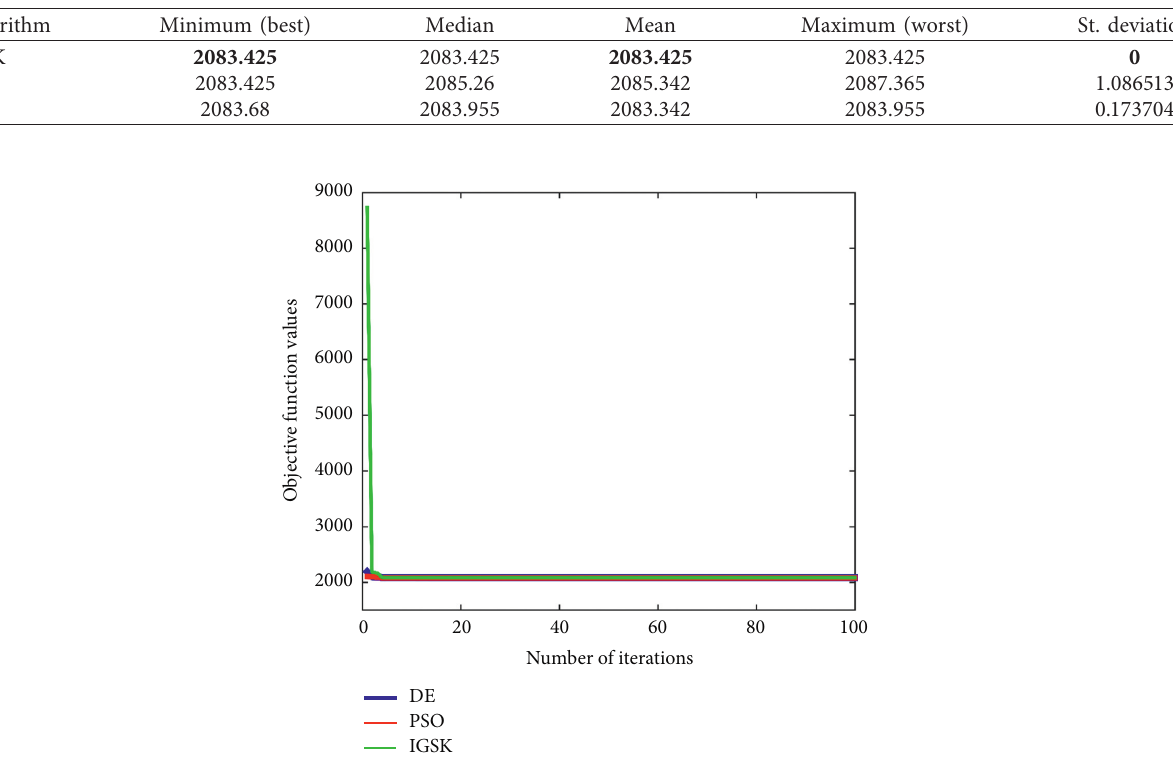
Table 4: Statistical analysis of obtained solutions of the problem.